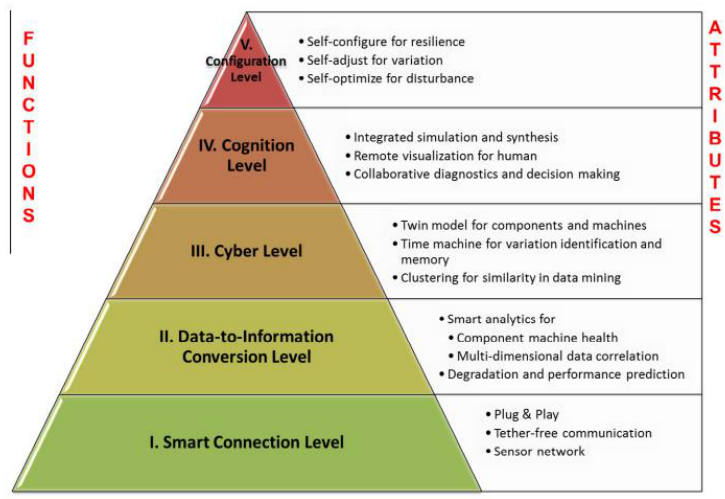
Figure 9. 5C architecture for the implementation of a CPS [83].